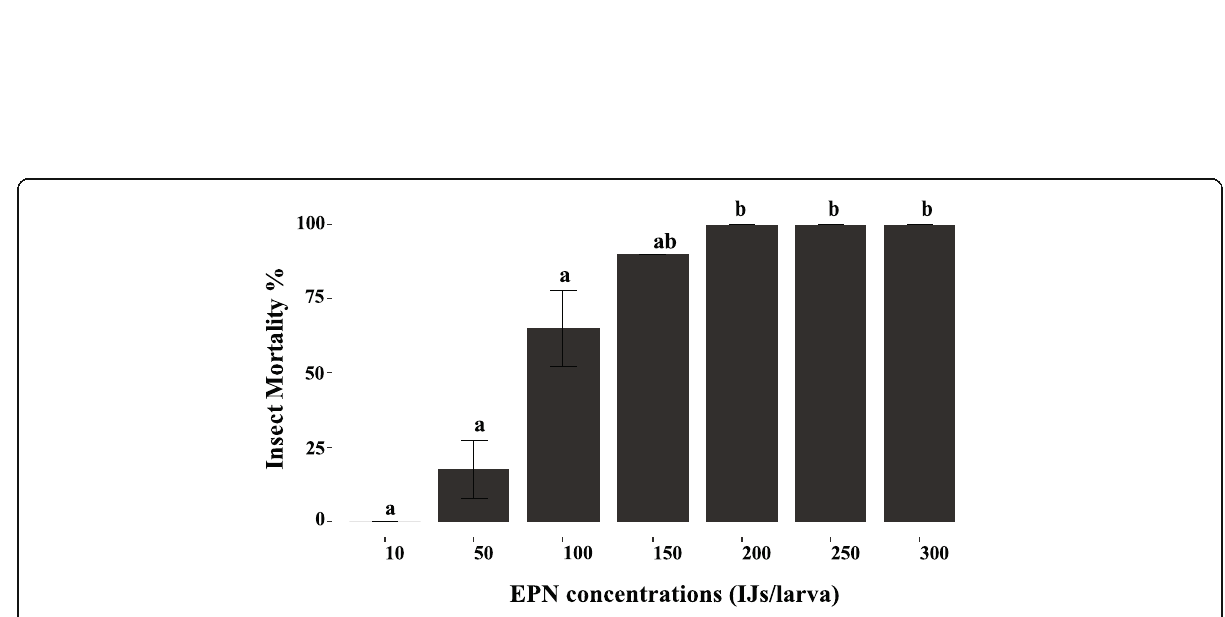
Fig. 3 Mean percentage mortality of Spodoptera litura third instar larvae after exposure to different dosages (IJs/larva) of the entomopathogenic nematode Heterorhabditis indica (PIGCD isolate) 24 h post inoculation at 25±2 °C. Error bars indicate standard deviation of four replicates. Different letters next to the error bars indicate significant differences with Dunn ’ s test for multiple